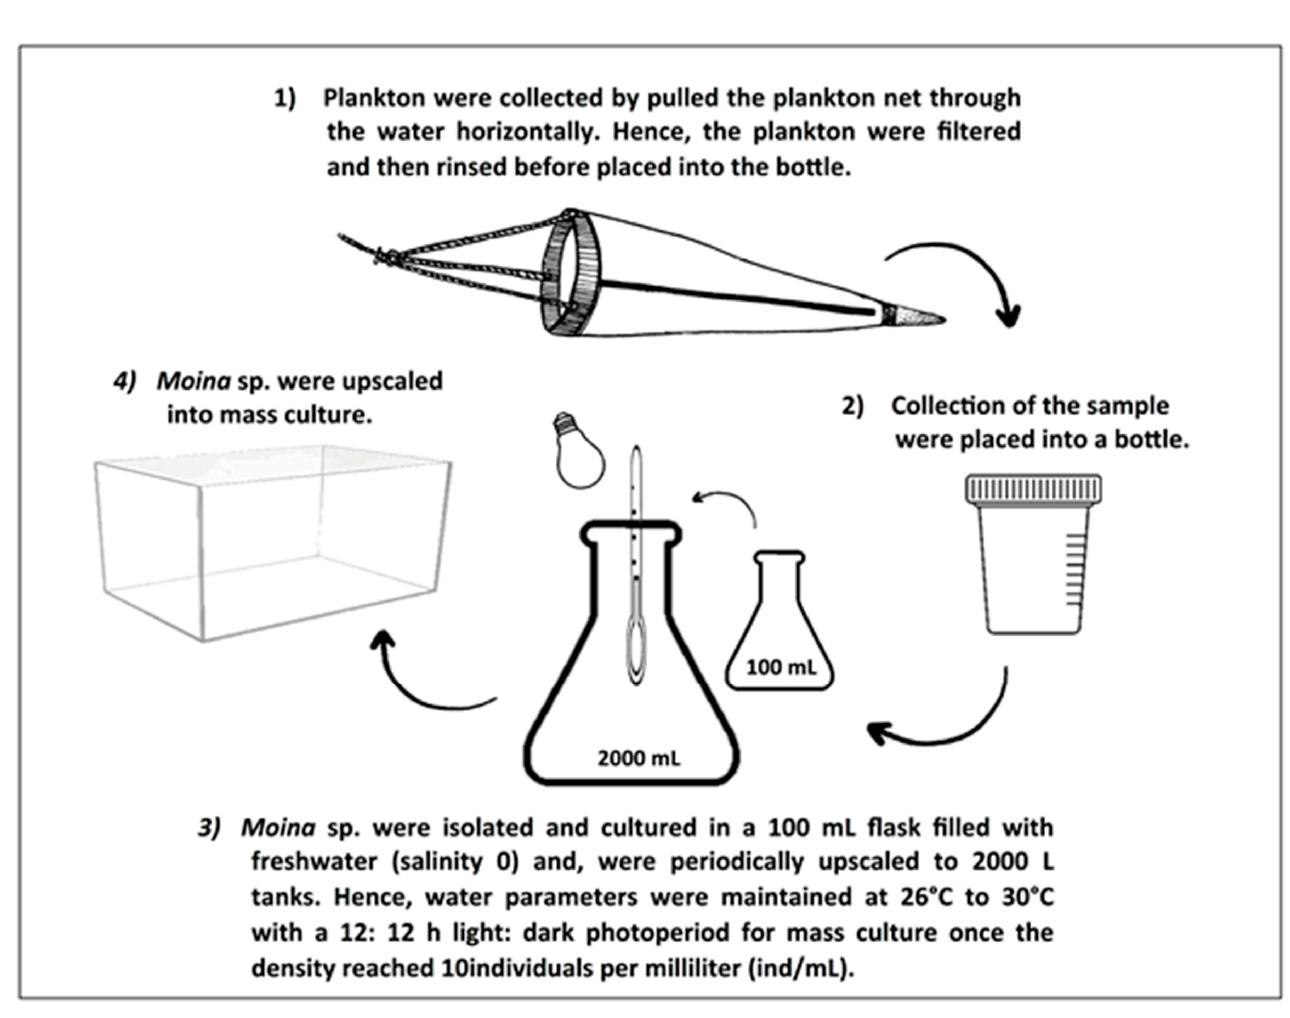
Figure 2. Illustration of the sampling method of Moina sp. The average percentage survival of M. macrocopa was determined every alternate day by using a zooplankton counting chamber. The initial density was known, the final density of M. macrocopa was then recorded to generate a survival estimate (final density divided by initial counted density). The growth of M. macrocopa was determined with 10 individuals daily by measuring body length (from the base of the caudal spine to the anterior edge of the head) with a projection microscope. The experiment was carried out for 15 days until the entire cohort died. This experiment was conduct by using the equation by Pianka 1988 [32] to measure the reproductive capacity of M. macrocopa , and life tables were used to record and analyze reproduction data. The life table variables included the initial age at maturation, longevity (days), survival/survivorship, average longevity, gross reproduction rate, net reproduction rate, generation time, and life expectancy. These variables were estimated as